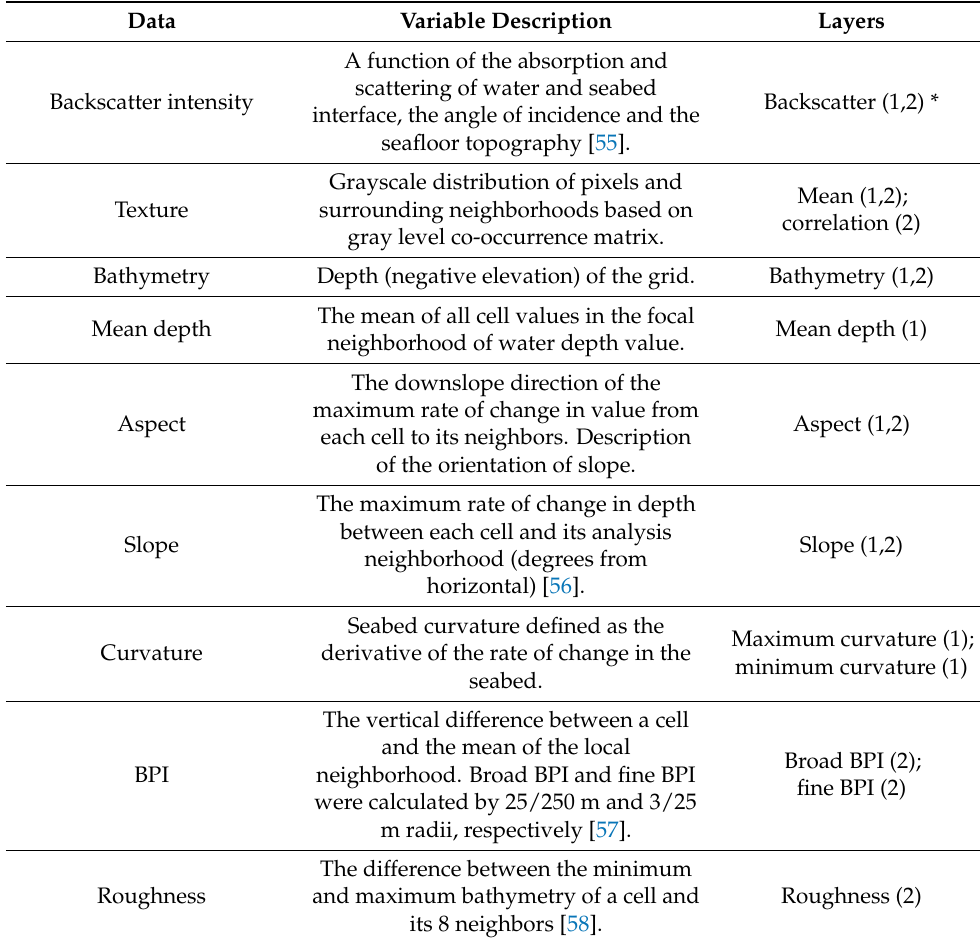
Table 2. Backscatter and topographic characteristics extracted from MBES